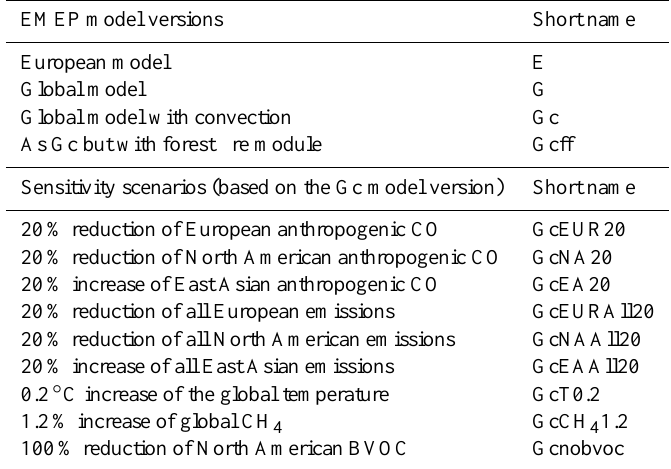
Table 3. EMEP model versions and sensitivity scenarios used in this